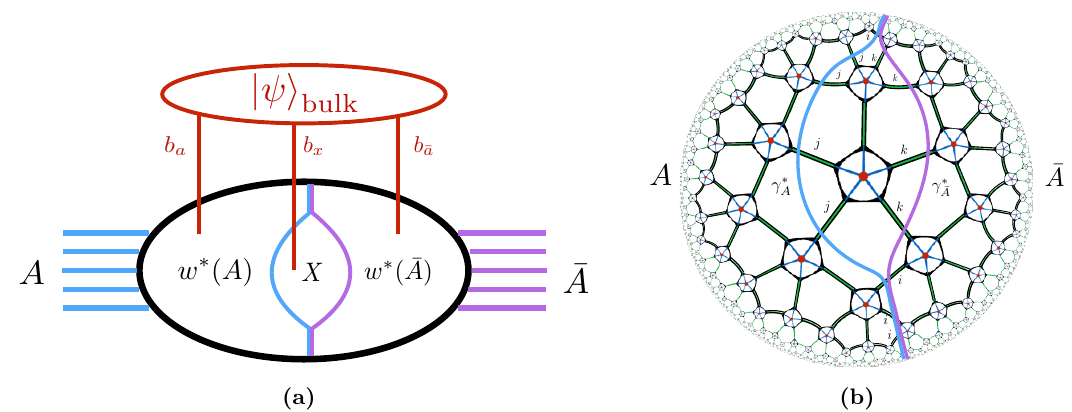
Figure 6. In (a) the network that computes the boundary state, broken into pieces corresponding to the wedges w (cid:3) ( A ), w (cid:3) ( (cid:22) A ), and the residual region X . In general all three regions receive inputs from bulk legs. In (b) we label the links cut by (cid:13) (cid:3) ( A ) and (cid:13) (cid:3) ( (cid:22) A ) with j and k respectively, and the links cut by both with i .